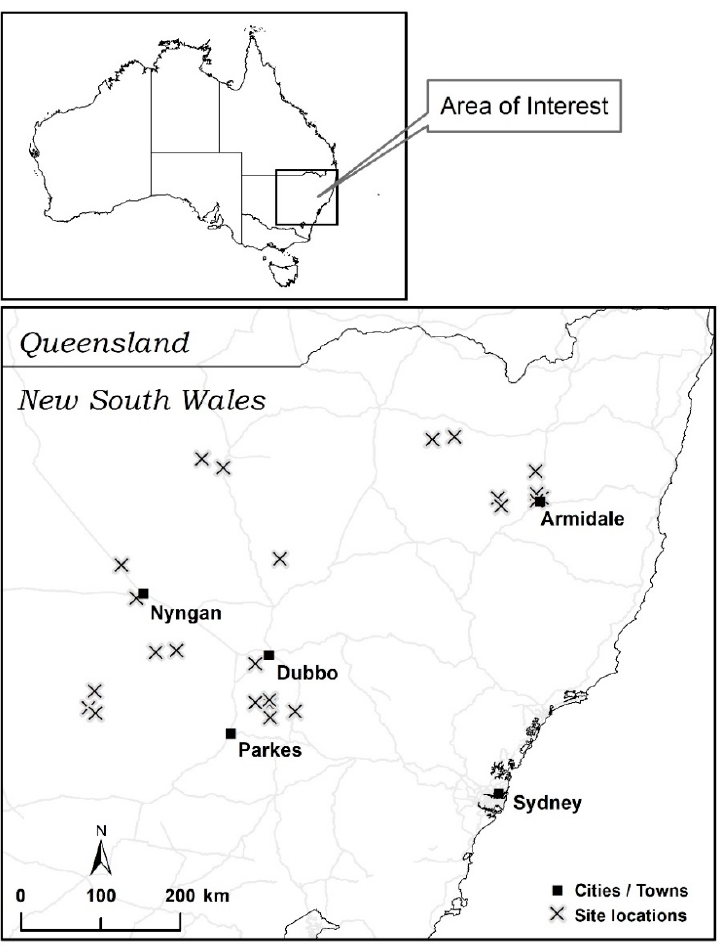
Soil Syst. 2019 , 3 , x FOR PEER REVIEW Figure 2. Location of sites used in study from New South Wales, Australia. Figure 2. Location of sites used in study from New South Wales, Australia.